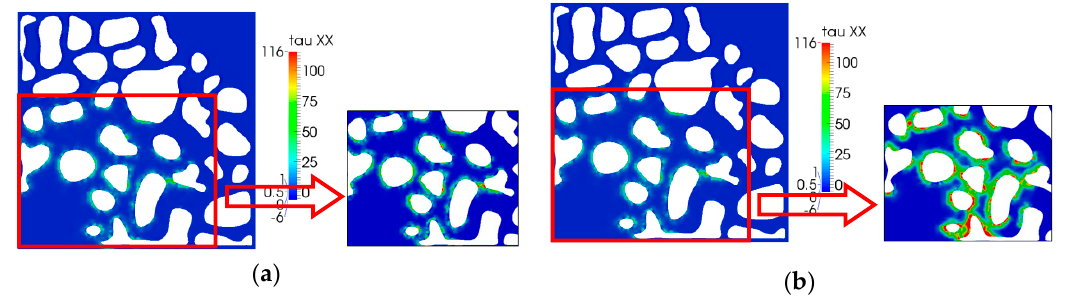
Figure 12. First normal stress ( τ xx ) distribution: ( a ) λ = 0.01 s; ( b ) λ = 0.05 s.